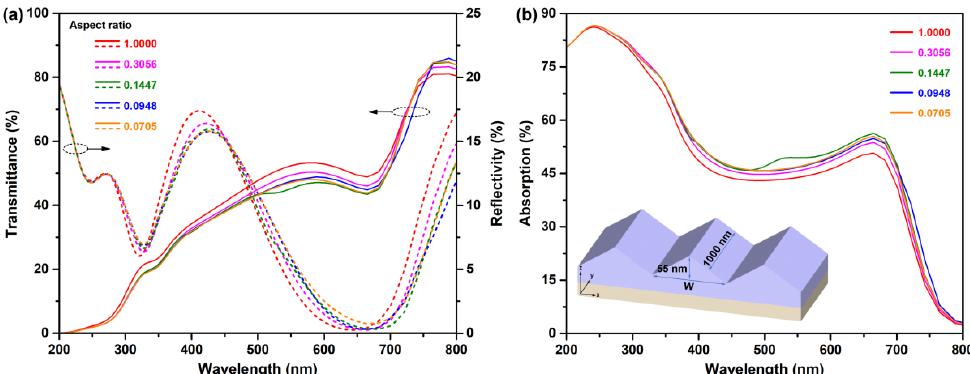
Figure 8. ( a ) Transmission and reflection spectra of the textured surface with different aspect ratios of the SANR structures and ( b ) corresponding absorption spectra. The inset demonstrates the structural parameters of the numerical model; the height was fixed at 55 nm and the width was changed, thus changing the aspect ratio.